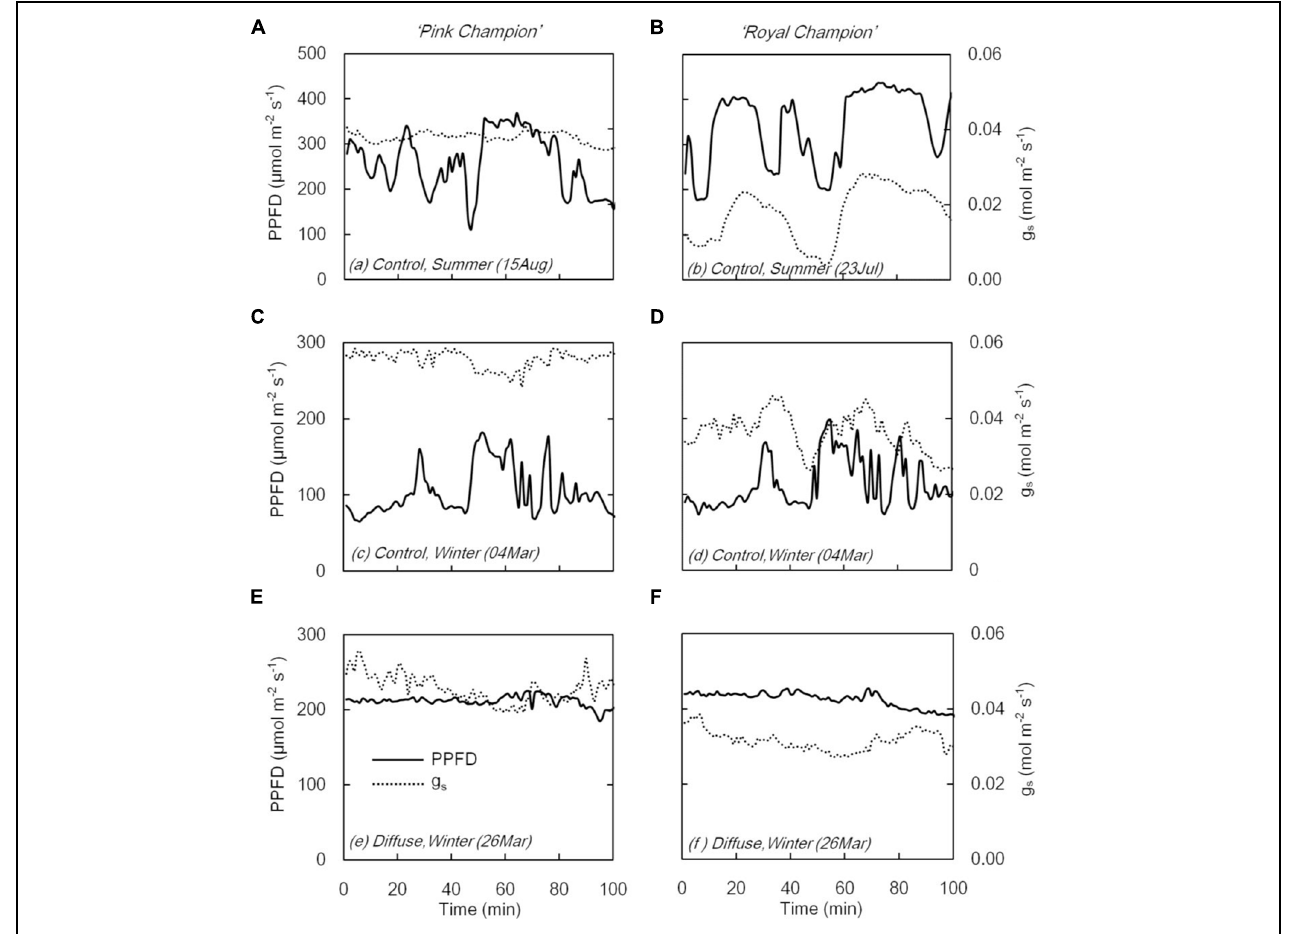
FIGURE 3 | Stomatal conductance ( g s , dashed line) and PPFD (solid line) in compartment with clear glass (control: A–D) and diffuse glass (E,F). ‘Pink Champion’ is shown in (A,C,E) and ‘Royal Champion’ in (B,D,F). The measurements were taken at 1 min